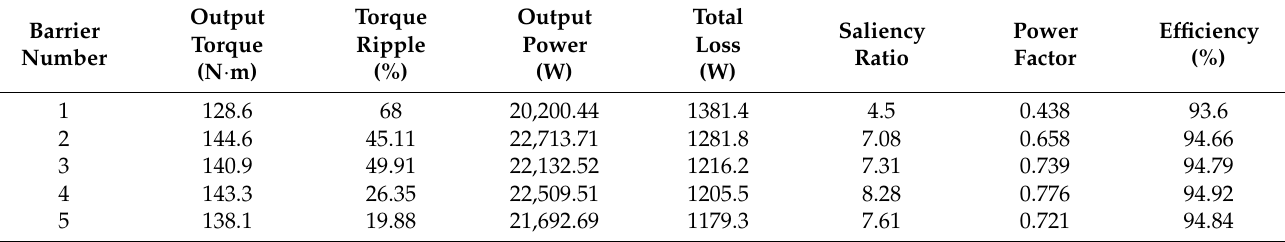
Table 2. Flux barrier number